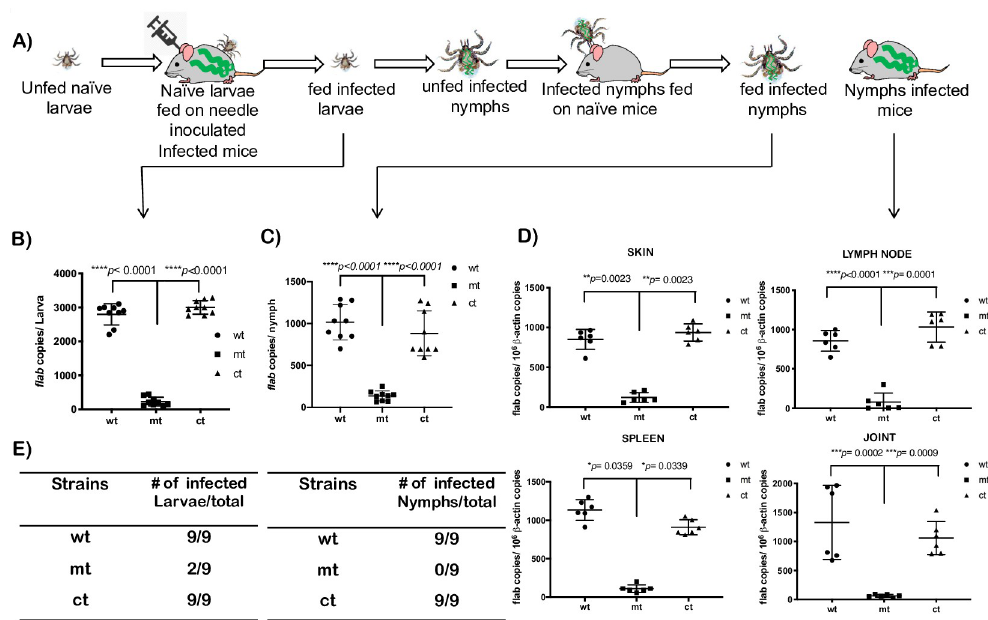
Fig 9. Quantitative real-time PCR analysis of the spirochetal burden in mice challenged with the bpiP mutant via I . scapularis nymphs. (A) Schematic representation of the experimental plan used in mouse-tick-mouse cycle of Bb infection. Na ï ve I . scapularis larvae were fed to repletion on C3H/HeN mice infected with wt, mt or ct strains with 10 5 spirochetes per mouse via needle inoculation. Bb burden in a proportion of fed larvae (3 per mouse) determined by (B) qPCR or (E) examined for the presence of spirochetes by dark field microscopy. Another proportion of fed larvae were allowed to molt to nymphs in an incubator maintained at 22˚C with 90% humidity and a 15-hour light /9-hour dark cycle. Groups ( n = 3) of 4-week-old na ï ve C3H/HeN female mice were challenged with 10 infected nymphs and after nymphs fed to repletion. Bb burden was determined from 3 nymphs per mouse by ( C ) qPCR or ( E ) examined for the presence of spirochetes in the midgut by dark field microscopy Infectivity analysis was done at day 14 post-infection by propagating several tissues for the presence of spirochetes (Table 3). A portion of spleen, one lymph node, spleen and one joint was used to extract total genomic DNA and (D) Bb burden was determined quantitative real time PCR. The infectivity analysis was done twice and results of both the experiments are reported together for mice infected with nymphs. Numbers of borrelial flaB copies were normalized against total mouse β -actin copies. The differences between the number of wt and mt or mt and ct in mouse tissues were statistically analyzed using a one-way analysis of variance test with Tukey’s multiple-comparison test. Statistical significance was accepted when p values were less than 0.05.